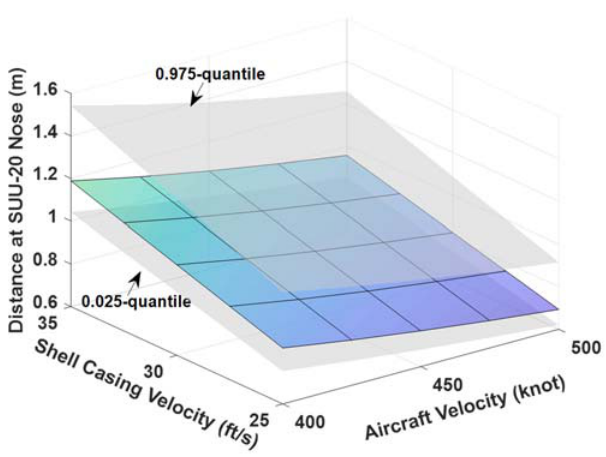
Figure 10. Sensitivity analysis results.